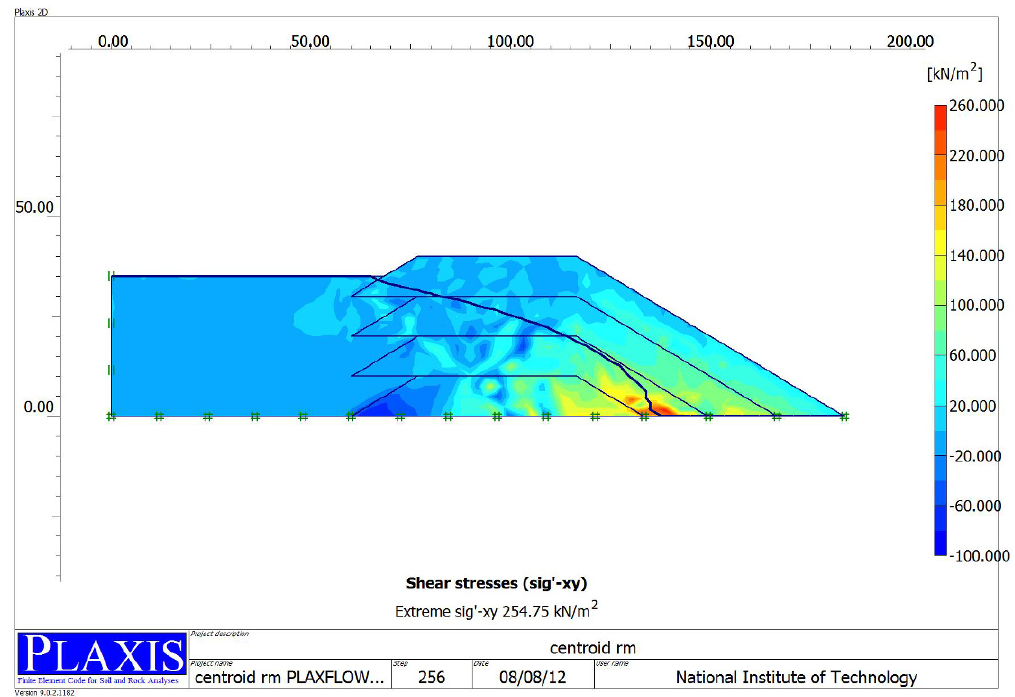
Figure 15. Effective stress diagram of centroid method dam in ZZ direction